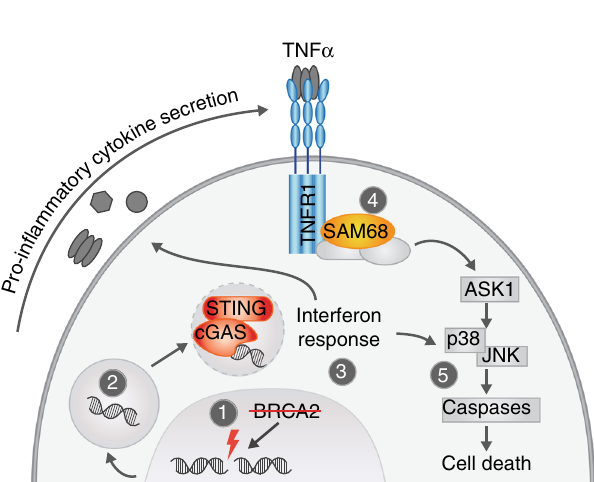
Fig. 7 Schematic model of in fl ammatory signaling upon BRCA2 inactivation. BRCA2 inactivation (1) leads to micronuclei formation (2) and cGAS/ STING-dependent activation of an interferon response (3). This leads to pro-in fl ammatory cytokines production, and sensitivity to TNF α , in a